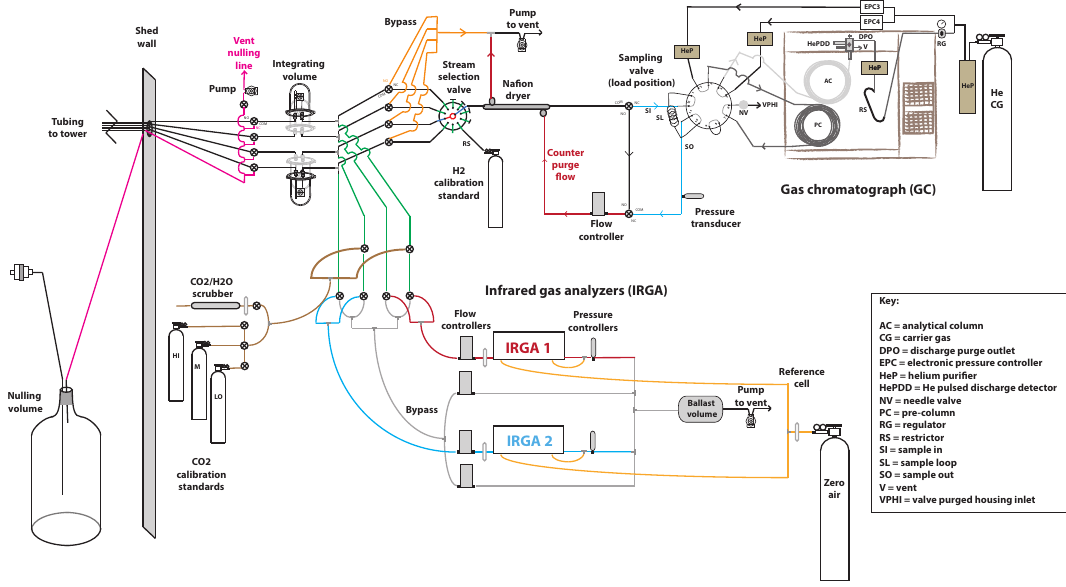
Figure 1. Schematic of the flux-gradient instrument system, which includes a gas chromatograph (GC-HePDD, H 2 measurements), infrared gas analyzers (IRGA, CO 2 , and H 2 O measurements), and the gas stream selection